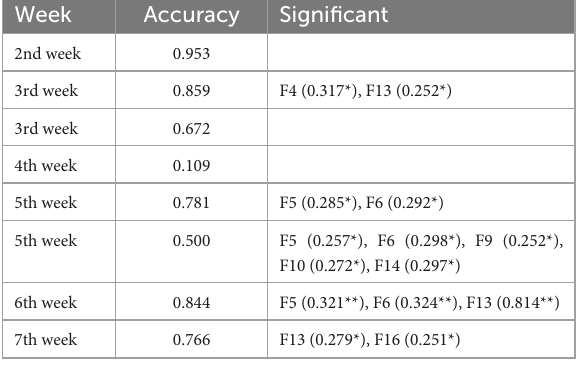
TABLE 1 Comparison of the accuracy (ACC) of submissions and the significant positive correlations in each